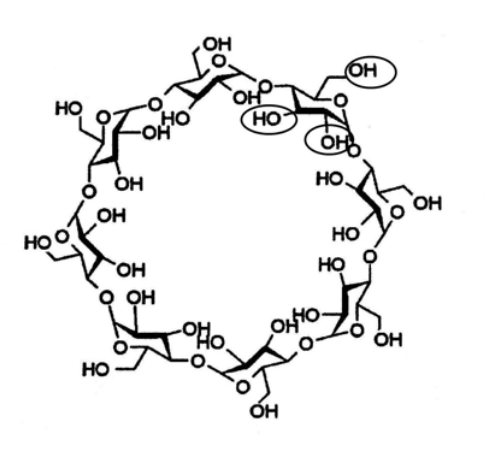
FIGURE 5. Modification sites of gamma cyclodextrin on 2 nd , 3 rd , and 6 th carbon (circled). Rreprinted with permission Wacker Chemical Corp. Adrian MI.